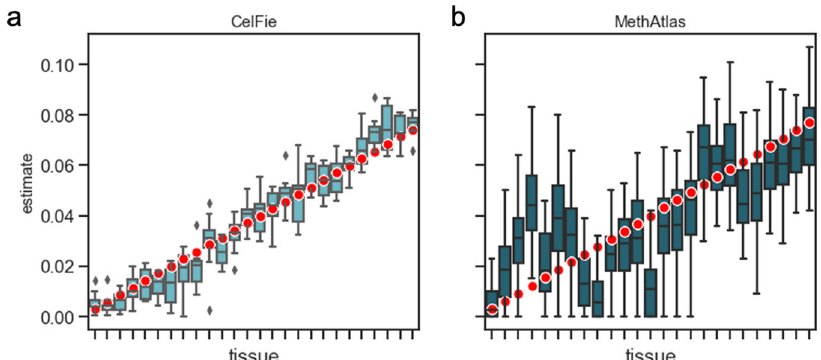
Fig. 1 Decomposition of simulated cfDNA mixtures by CelFiE (A) and MethAtlas (B). 50 replications for a single simulated individual were performed, and the estimated mixing proportions were plotted (light blue and dark blue boxes, respectively). The red dots indicate the true cell type proportion for each simulated tissue. The center line of the box indicates the mean, the outer edges of the box indicate the upper and lower quartiles, and the whiskers indicate the maxima and minima of the distribution.